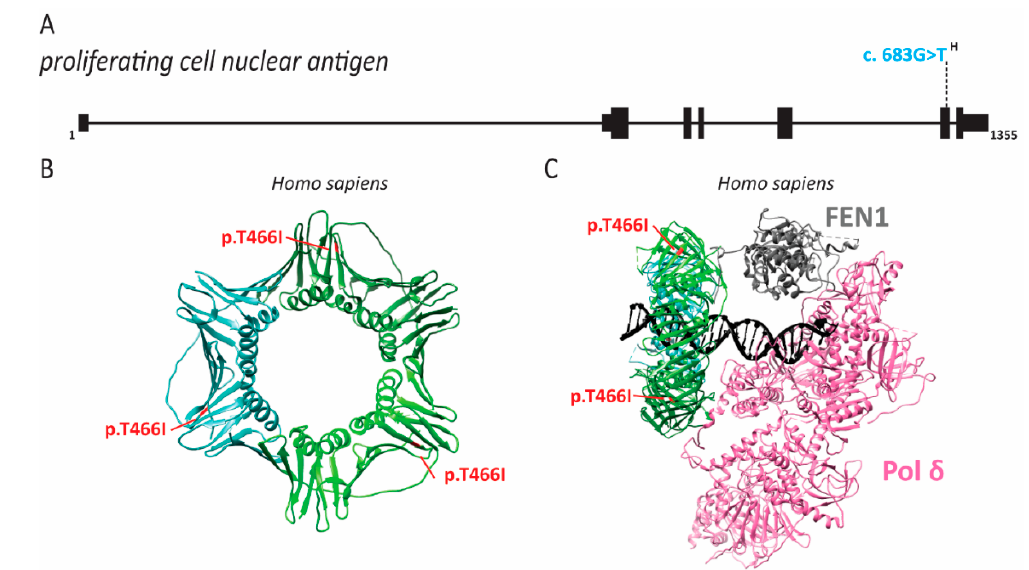
Figure 11. PCNA pathogenic variant is on the outer surface of PCNA. Pathogenic mutation in PCNA is depicted on a schematic of the gene and crystal structure of Homo sapiens proteins. Structures were generated with the Chimera program (http://www.cgl.ucsf.edu/chimera). Exon and intron schematics were generated with the UCSD genome browser. Reference sequence is NM_002592.2. Schematic of the ( A ) PCNA gene is depicted with exons as black boxes and introns as horizontal lines. Missense mutation is mapped to the appropriate gene regions. “H” superscript indicates a homozygous mutation. ( B ) Crystal structure of human PCNA with missense mutation depicted in red. The structure was generated using pdb file 6fcm. ( C ) Crystal structure of human PCNA in complex with FEN1 and pol δ with missense mutation depicted in red. The structure was generated using pdb file 6tnz.